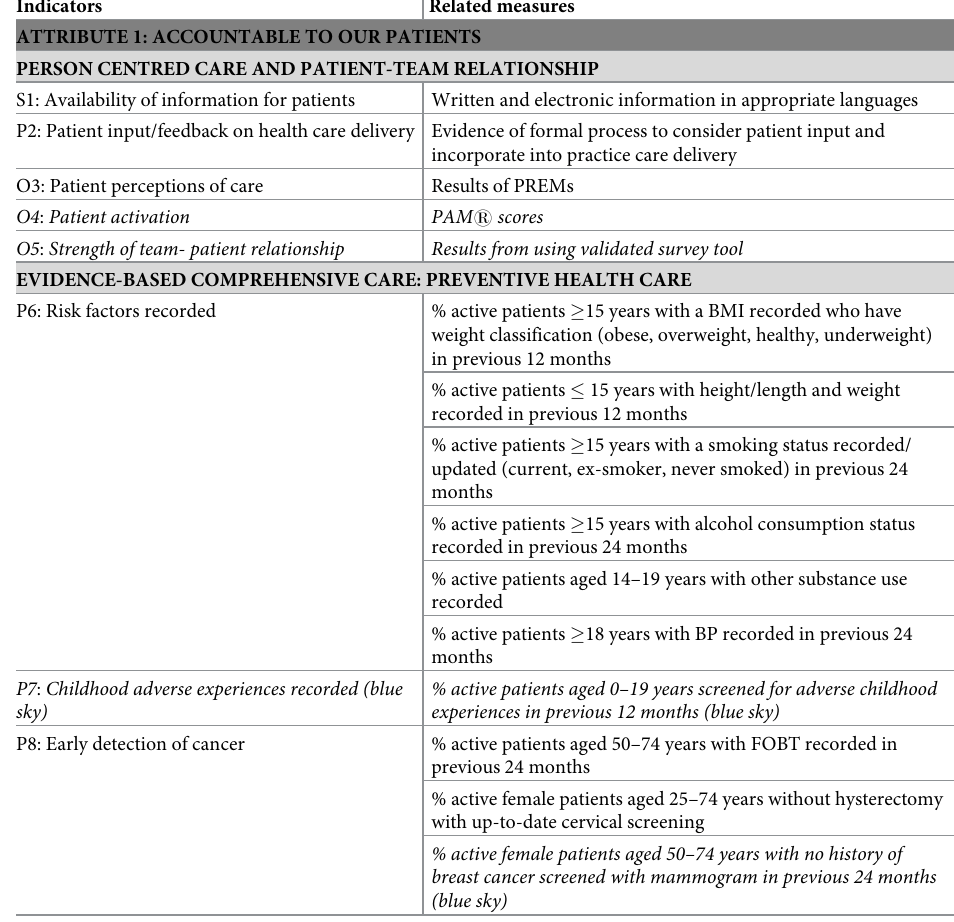
Table 2. Indicators and measures for assessment by